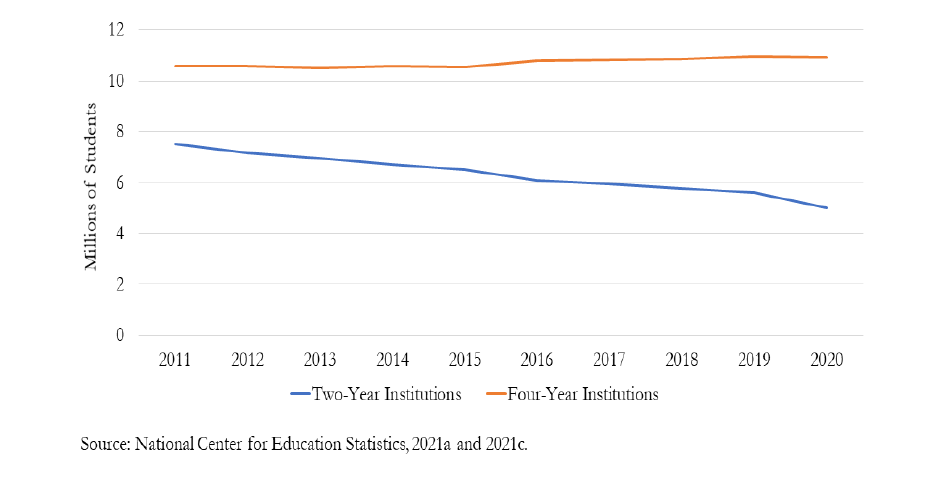
Figure 1: Total Fall Undergraduate Enrollment,